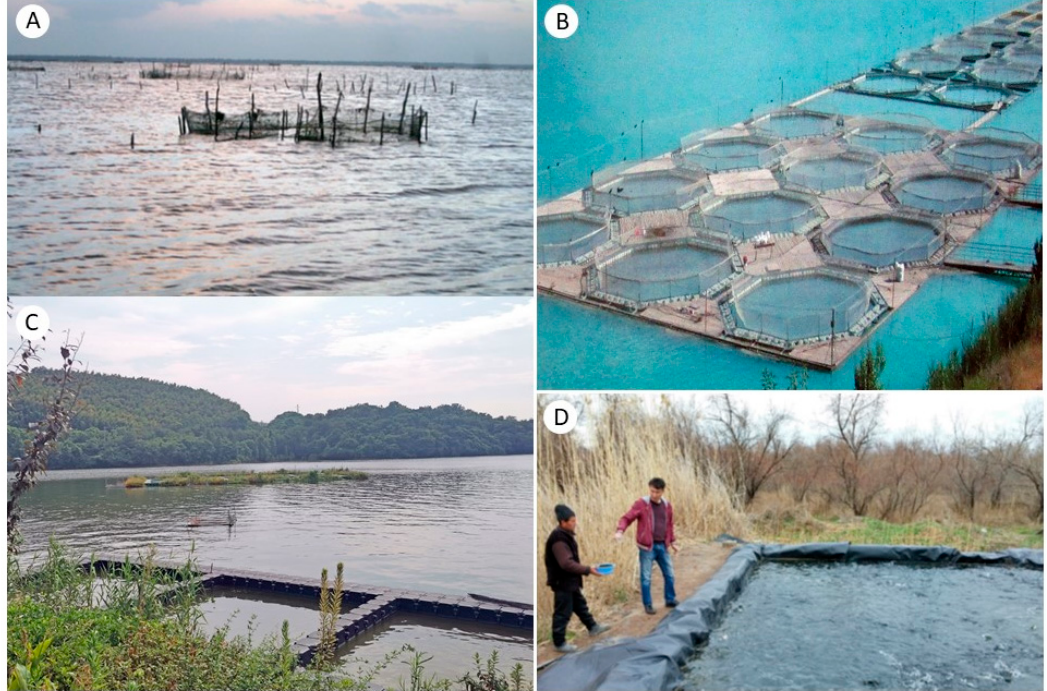
Figure 1. Examples of aquaculture facilities. ( A ). Simple fish cages in Sri Lanka. ( B ). Modern intensively managed fish pens in Uzbekistan. ( C ). Modular fish enclosures in China. ( D ). Plastic-lined fish pond in Kazakhstan. Picture credits: ( A ) and ( D ), S. Pueppke; ( B ), N. Graham; ( C ), W. Zhang.